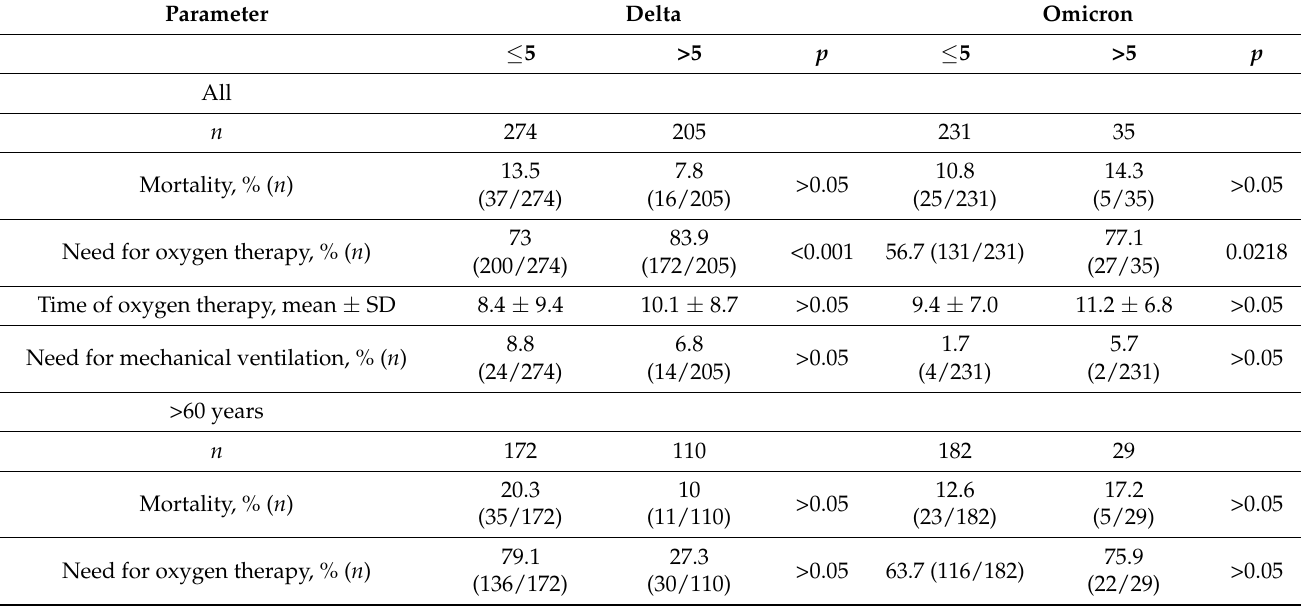
Table 7. Endpoints considering the time of RDV treatment initiation: within 5 days of symptom onset versus more than 5